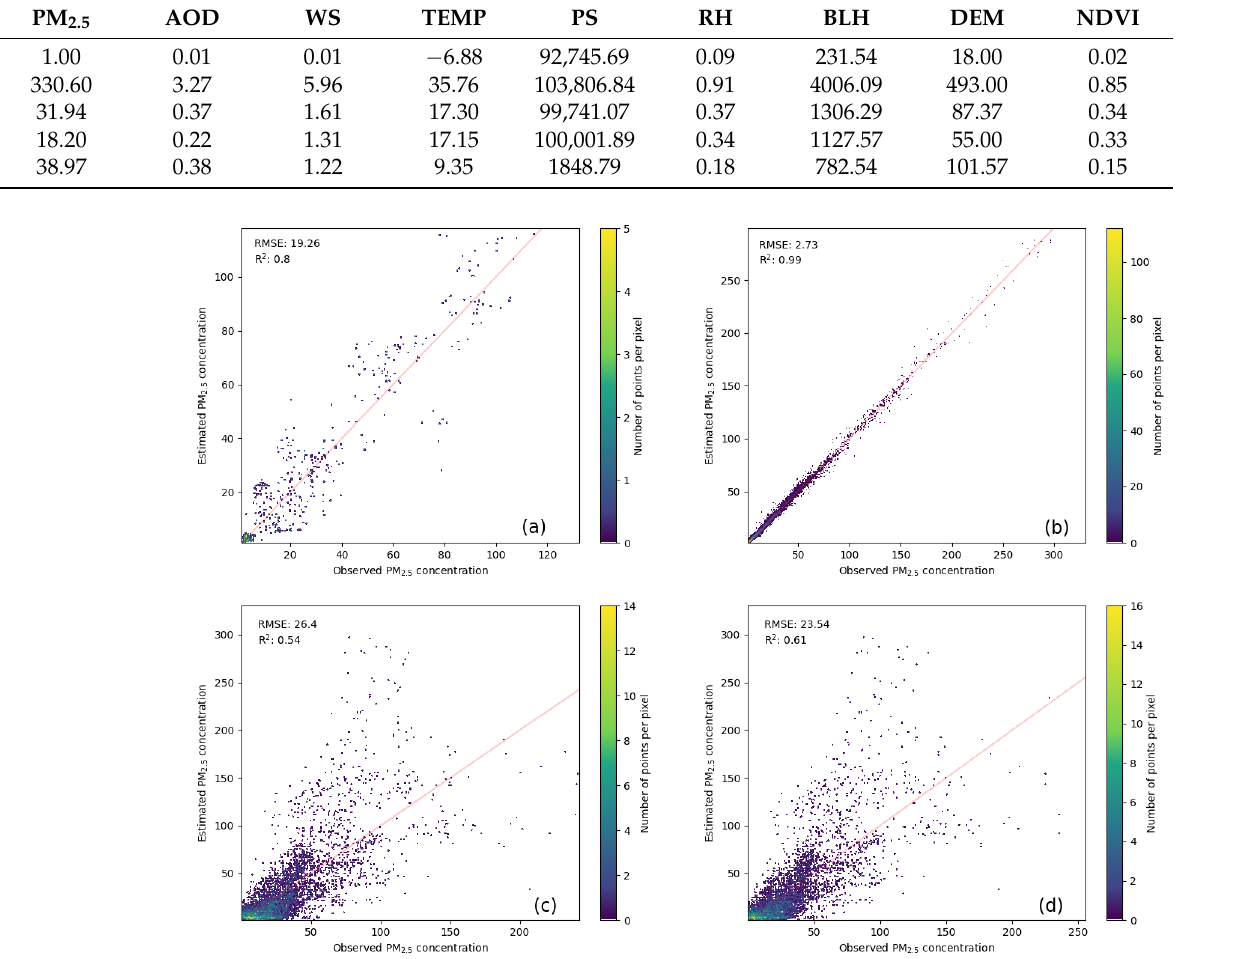
Figure 8. Density scatter plots of PM 2.5 concentrations measured at ground-based monitoring stations and PM 2.5 concentrations estimated by various methods. The data in ( a – d ) are the testing data and training data for AutoELM, and the CV results of OLS regression and GWR, respectively. The red dashed lines represent the 1:1